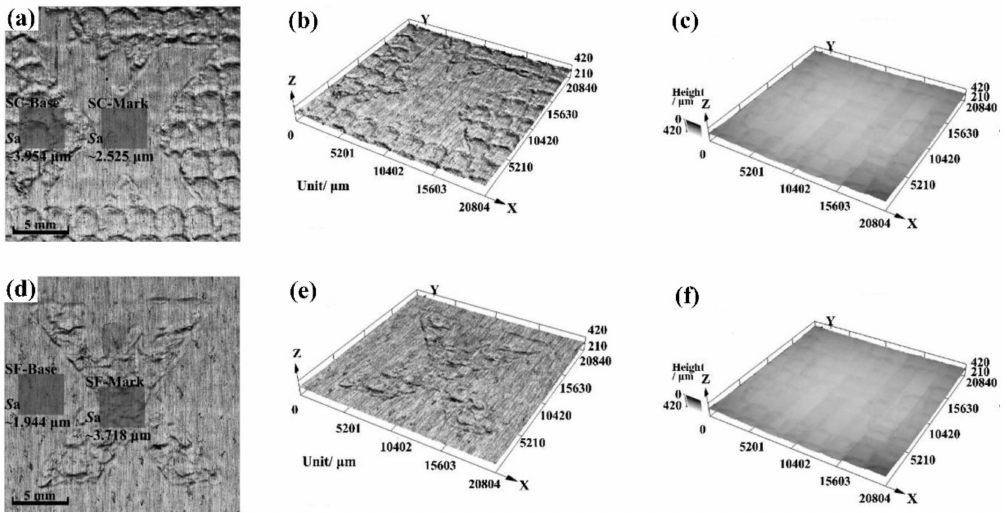
Figure 15. The “X” letter marked by the LSM technology. ( a – c ) “shape controlling” marking pattern; ( d – f ) “shape forming” marking pattern